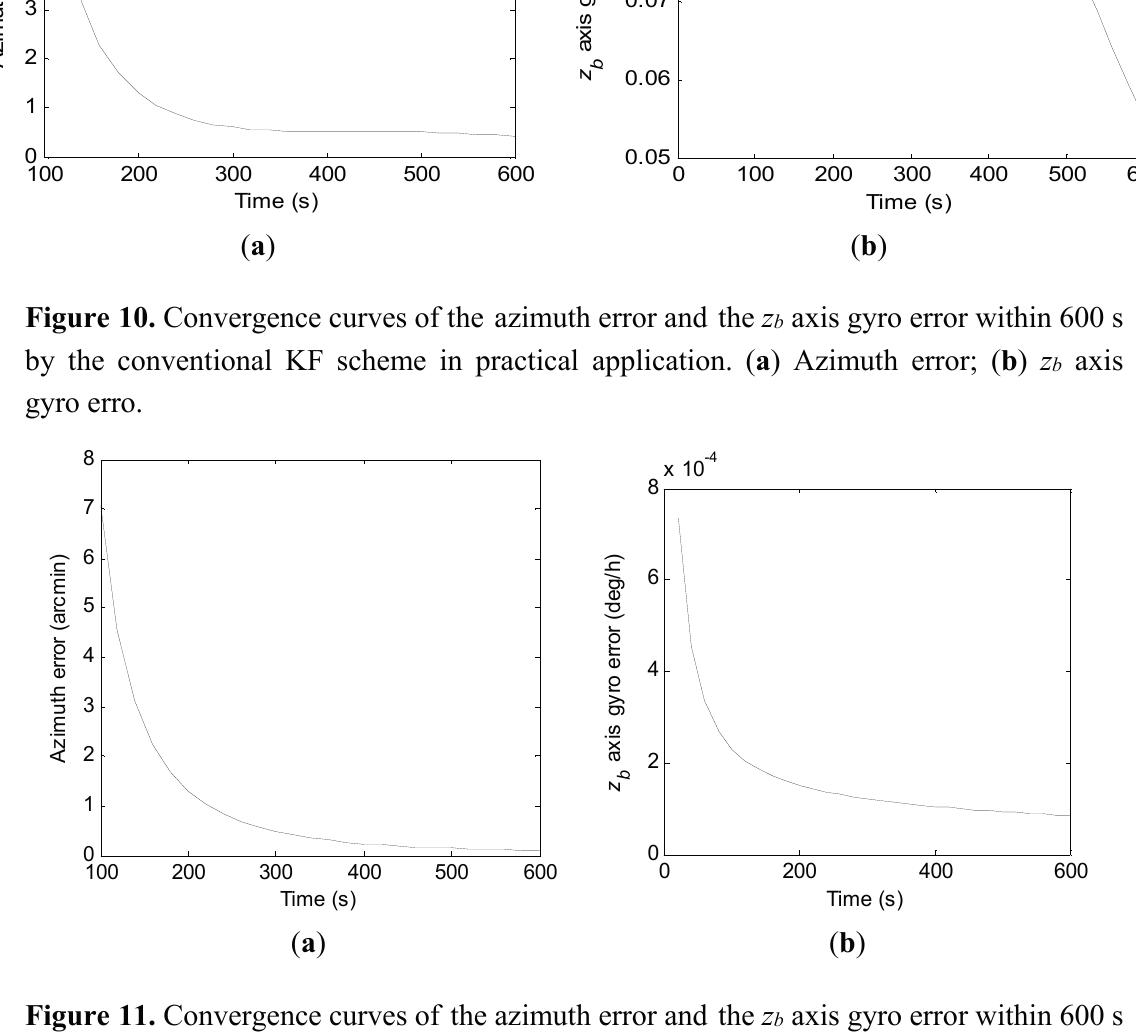
Figure 11. Convergence curves of the azimuth error and the z b axis gyro error within 600 s by the constrained KF scheme in practical application. ( a ) Azimuth error; ( b ) z b axis gyro